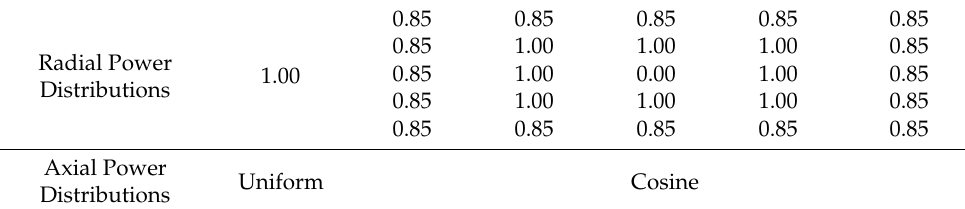
Table 4. 1 × 1 and 5 × 5 power distributions from the PSBT benchmark.